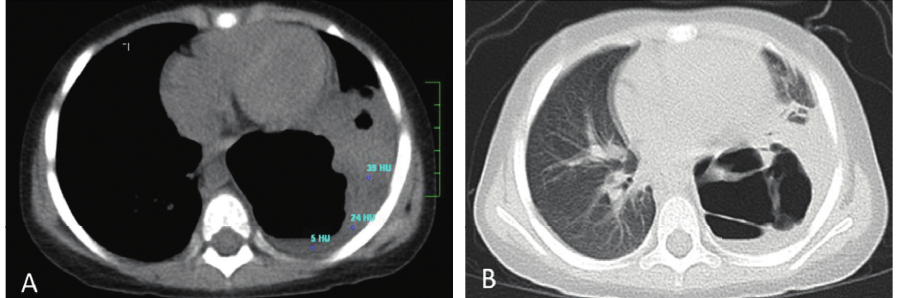
Figure 5: Noncontrast axial-chest CT: mediastinal window (a) and lung window (b). Left pleural effusion density was < 25 HU. There was a poorly visible portion of the left lung, and there was air-filled thin wall cavity. Without IV contrast, cavitary necrosis could not be diagnosed because there was no enhancement of the surroundings.